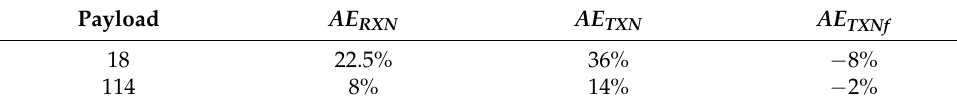
Table 4. Variation of energy consumption in the node with ID = 16 bits